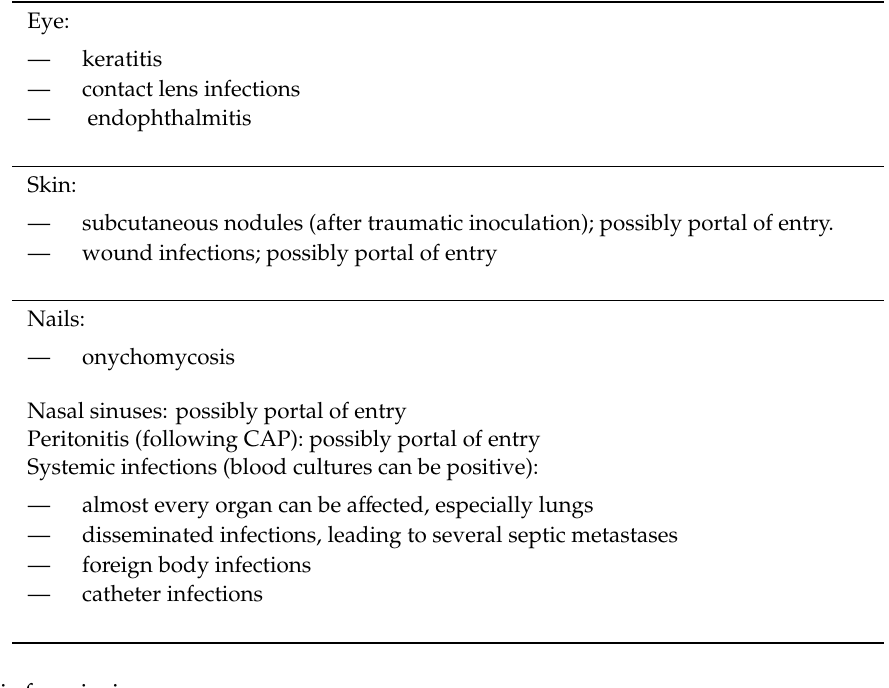
Table 3. Major clinical manifestations of infections with Fusarium spp. according to